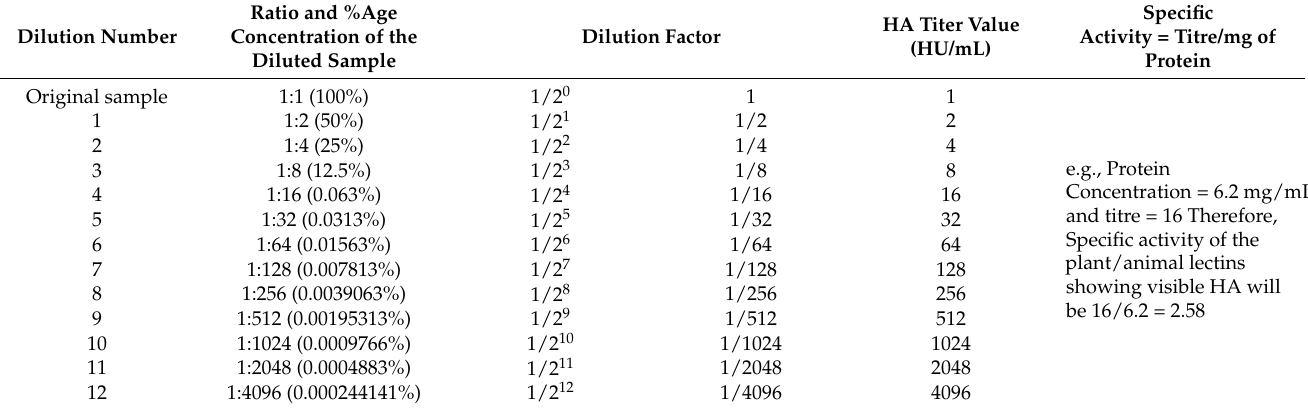
Table 2. Method of two-fold serial dilution, corresponding titer values, HA units/mL, and specific activity.